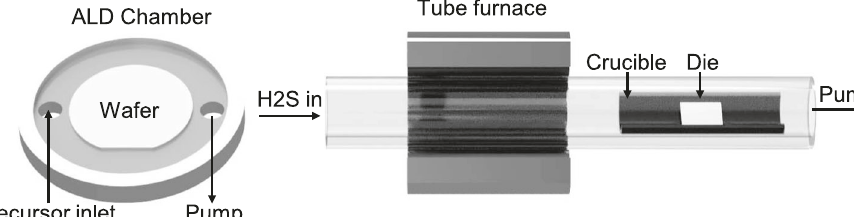
Fig. 9 Schematic of the experimental setup for the growth of the 2D fi lm. MoO 3 is grown in an ALD chamber while sulfurisation and crystallisation take place in a tube